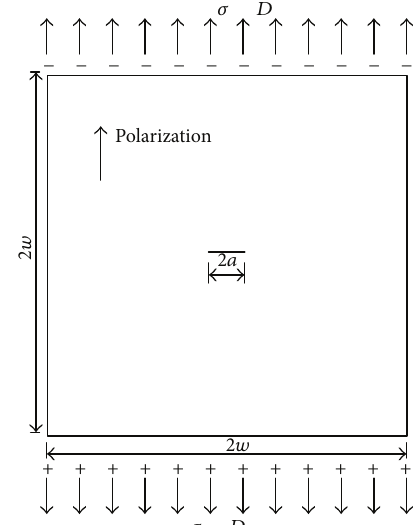
Figure 6: Electromechanical Griffith crack (uniaxial